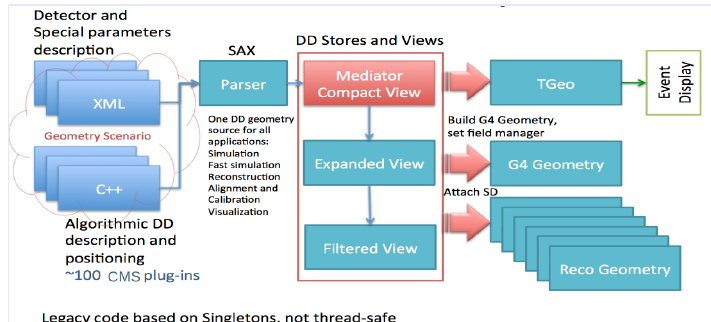
Figure 1. Diagram showing the existing CMS detector description. The old DD uses a SAX (Simple API for XML) parser, which parses XML step-by-step in a state-independent manner. In this diagram, "G4" refers to the Geant4 simulation toolkit, "Reco" refers to particle reconstruction, and "TGeo" refers to the ROOT geometry classes.